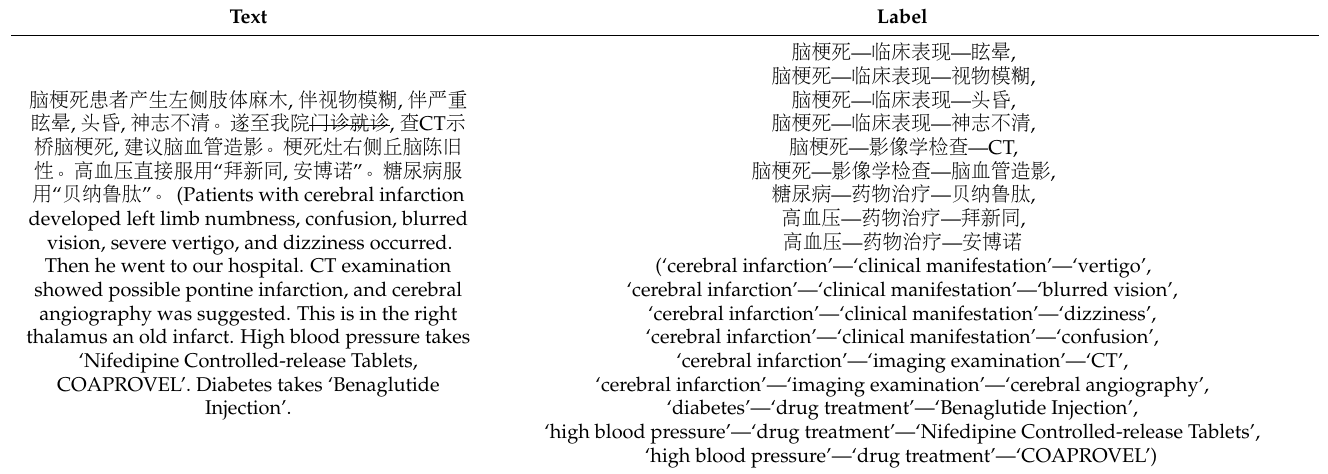
Table 9. Augmented data of the case study on RC